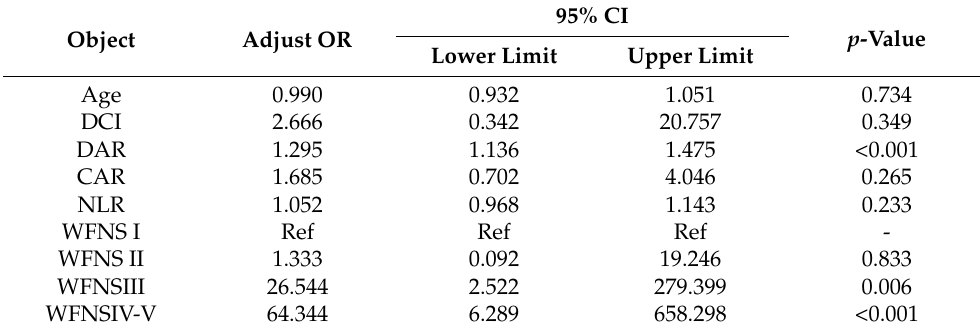
Table 3. Multiple logistic regression analysis to predict poor 3-month